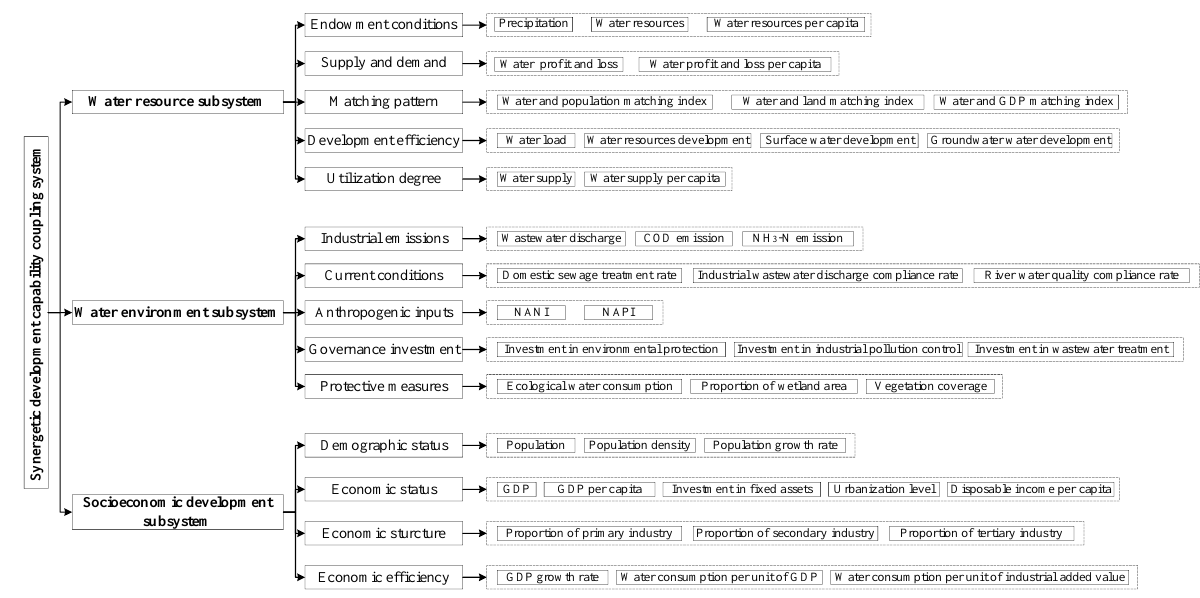
Figure 3. Evaluation index of the “water resource–water environment–socioeconomic development” coupling system.